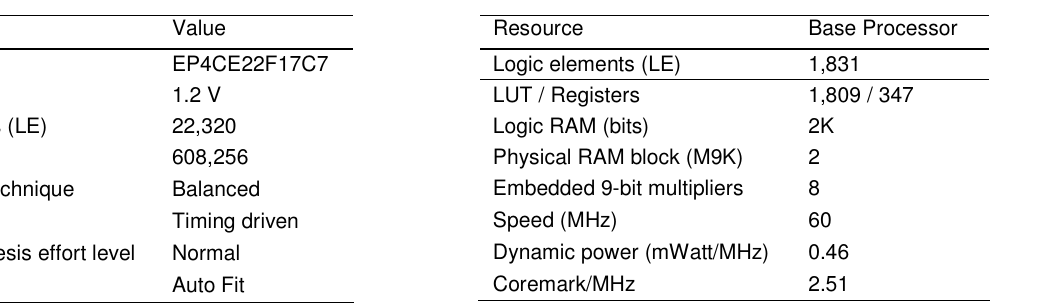
Table 4. FPGA implementation results.